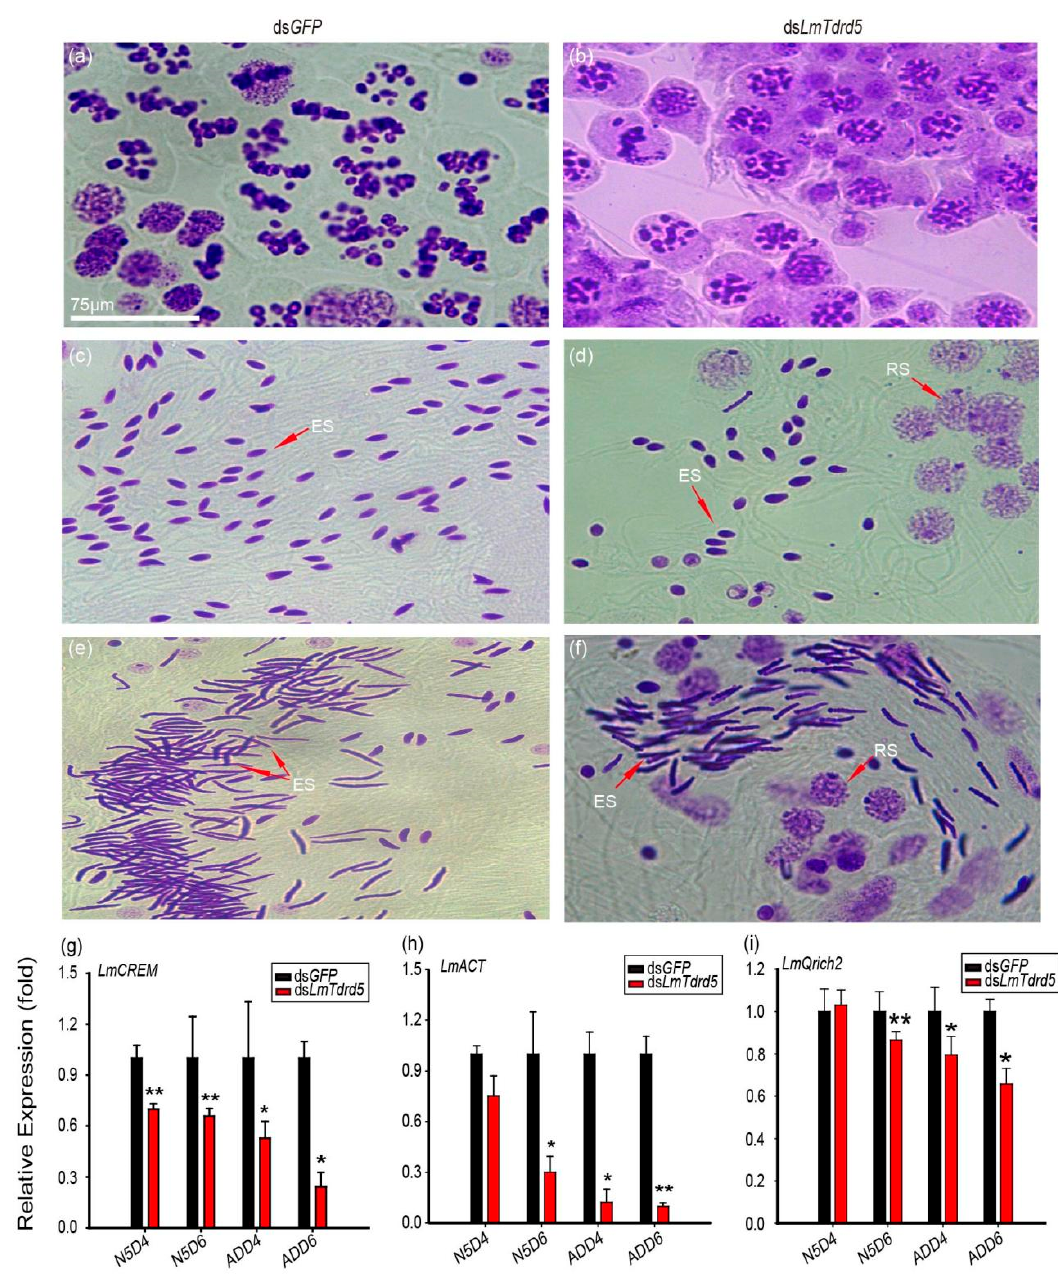
Figure 3. Defects in spermatogenesis of ds LmTdrd5- treated locusts. ( a – f ) Cytological phenotype of three representative stages during spermatogenesis observed at the transition zone of seminiferous tubules from testes stained with the improved phenol fuchsin stain. Purple represents chromatin. ( a , c , e ) Haploid germ cells in the meiotic II stage and elongated spermatids from ds GFP -treated testes. ( b , d , f ) Haploid germ cells in the meiotic II stage and elongated spermatids from ds LmTdrd5 - treated testes. Meiosis phase transition was delayed, and the sperm count was significantly reduced. RS, round spermatids; ES, elongated spermatids. ( g – i ) Effect of ds LmTdrd5 injection on LmCREM expression levels ( g ), LmACT ( h ), and Lm Qrich2 ( i ) in the testes on days N5D4, N5D6, ADD4, and ADD6 compared with the control ds GFP -treated locusts. Data are presented as mean ± standard error of the mean ( n = 9–15). Statistically significant differences are indicated as follows: * p < 0.05; ** p < 0.01.